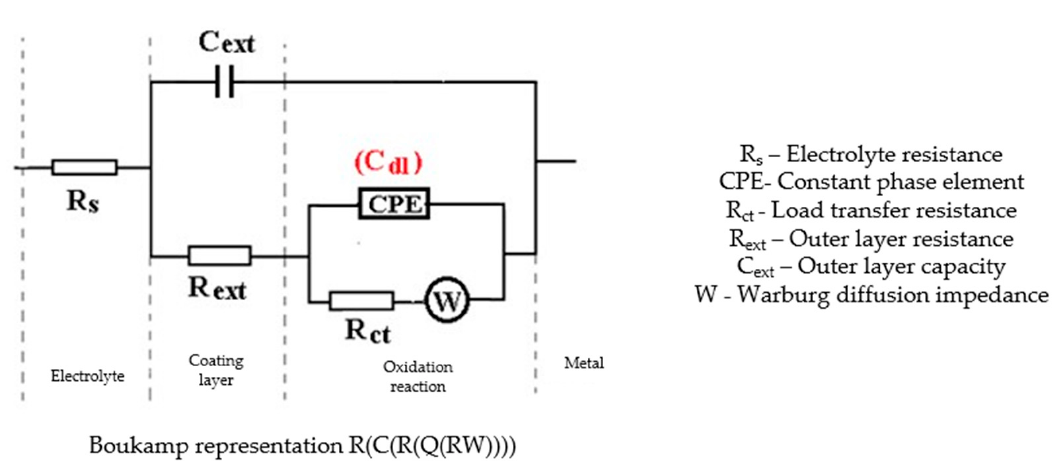
Figure 6. The equivalent circuit for C45 sample, after 85 days of immersion in